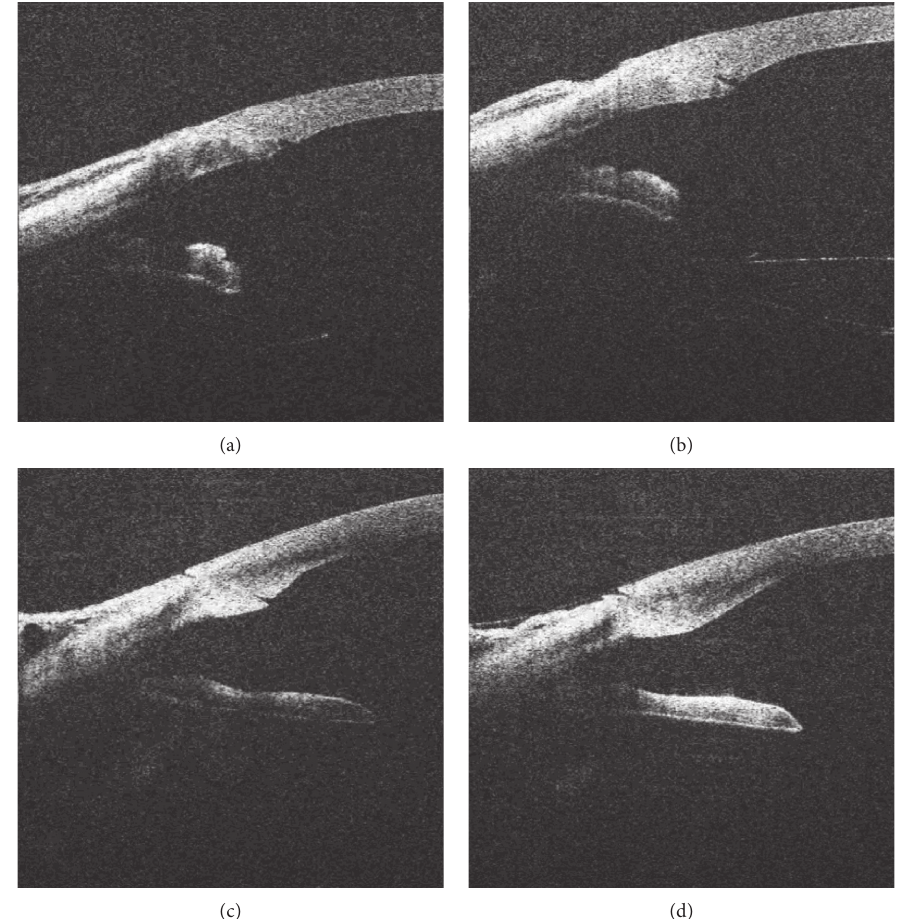
Figure 8: Improvement of corneal incision morphology after its hydration. Inverted tongue of the corneal incision before hydration (a) and after lateral stromal hydration inverted tongue strengthened up and slight prominence of posterior lip appeared (b). Prominence of the posterior lip (c); decrease after lateral stromal hydration